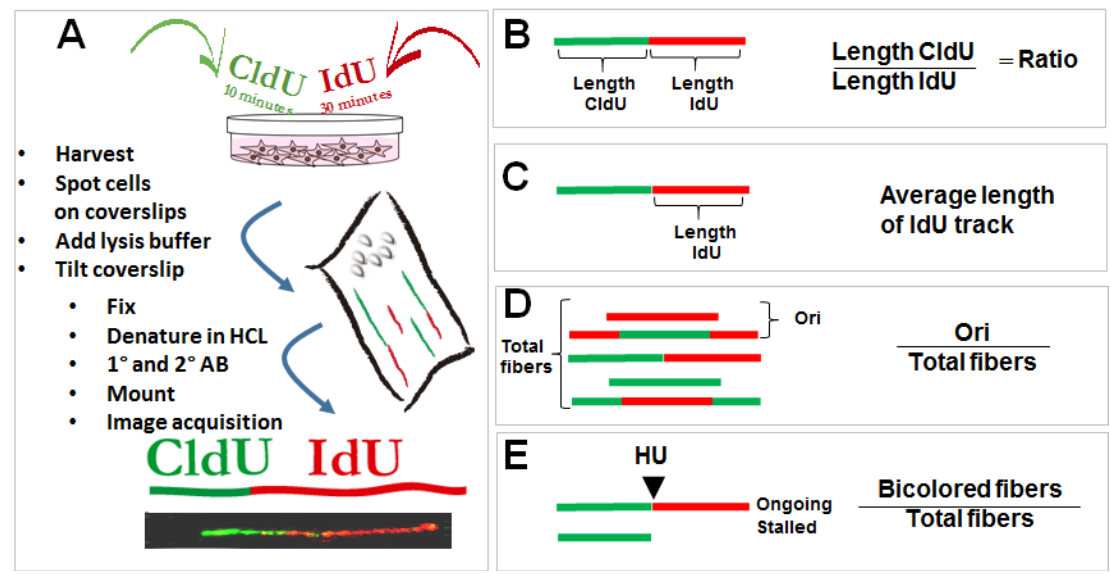
Figure 1. DNA spreading assay and protocols used to study the role of p53 in the regulation of DNA replication choreography. ( A ) Asynchronous cells are subjected to two subsequent incorporations of thymidine analogs (CldU and IdU). Immediately after the second pulse, samples are collected and harvested in denaturing conditions on a tilted coverslip. Cells are lysed while their content scrolls down the coverslip and DNA is spread on its surface. CldU and IdU are detected using specific antibodies. DNA track that incorporated the thymidine analogs are visualized as bicolored fibers.